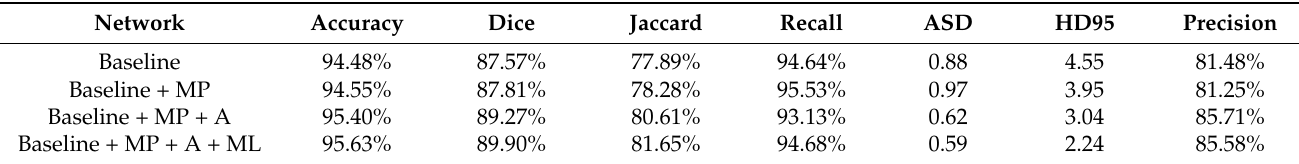
Table 3. Ablation experiment with the proposed method. MP: mid-pred module; A: attention module; ML: multi-loss.